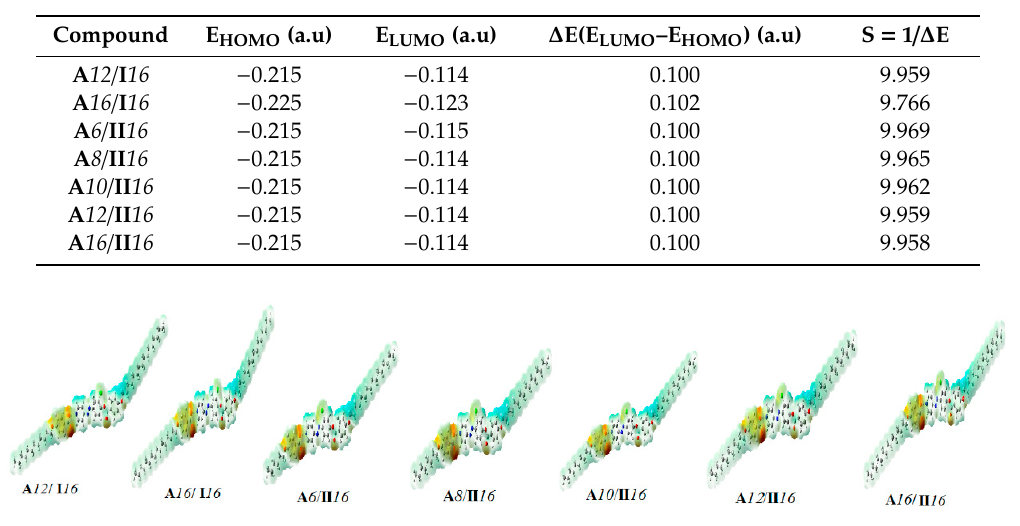
Figure 11. Molecular electrostatic potentials (MEP) of A 12 / I 16 , A 16 / I 16 and A n / II m .